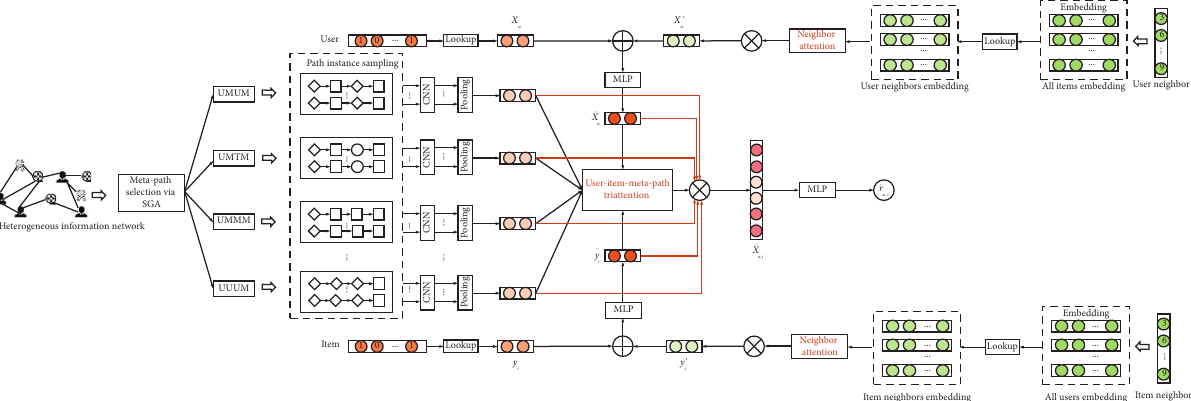
Figure 1: The whole architecture of the TANN